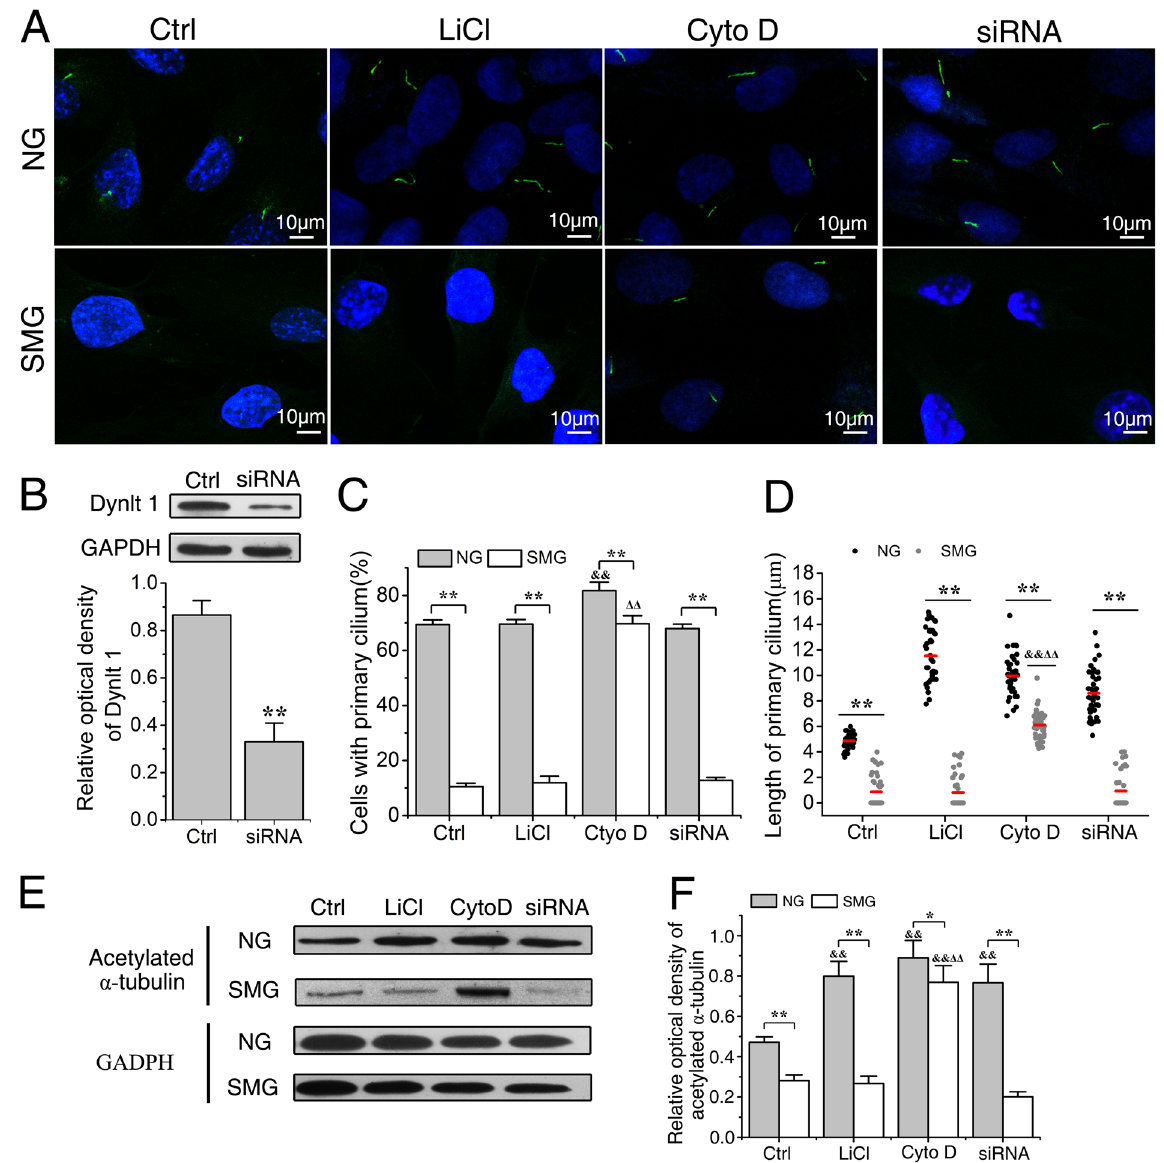
Figure 5. Elongation of cilia prevents the abrogation of primary cilia induced by simulated microgravity. ( A ) Immunofluorescence image of rat calvarial osteoblasts (ROBs) exposed to simulated microgravity (SMG) or normal ground (NG) for 24 h after being treated with 5 mM LiCl, 0.1 μ M cytochalasin D (Cyto D) or dynein light chain Tctex-type 1 (Dynlt1) siRNA. Primary cilia were stained with acetylated α -tubulin (green), and DNA were stained with DAPI (blue). ( B ) Treatment with Dynlt1 siRNA resulted in significant decreases in Dynlt1 expression at the protein levels. ( C ) Quantification of the percentage of cells with a cilium in each group. ( D ) Means (red bars) and individual measurements of cilium lengths in each group. ( E ) The protein expression levels of acetylated α -tubulin. Full-length Western blots are presented in Supplementary Figure 3 and Figure 4. Each experiment was conducted at least three times independently. * P < 0.05 or ** P < 0.01 vs NG group of each treatment; & P < 0.05 or && P < 0.01 vs Ctrl of NG group; △△ P < 0.01 vs Ctrl of SMG